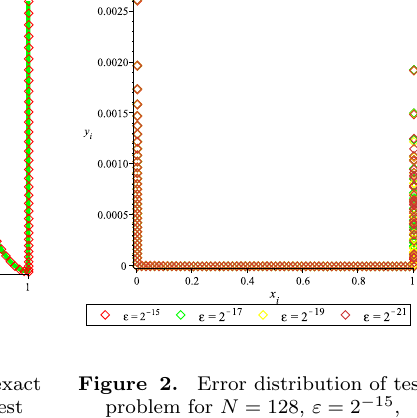
Figure 1. Comparison of the exact and approximate solutions of test problem for N = 128, ε = 2 − 15 .